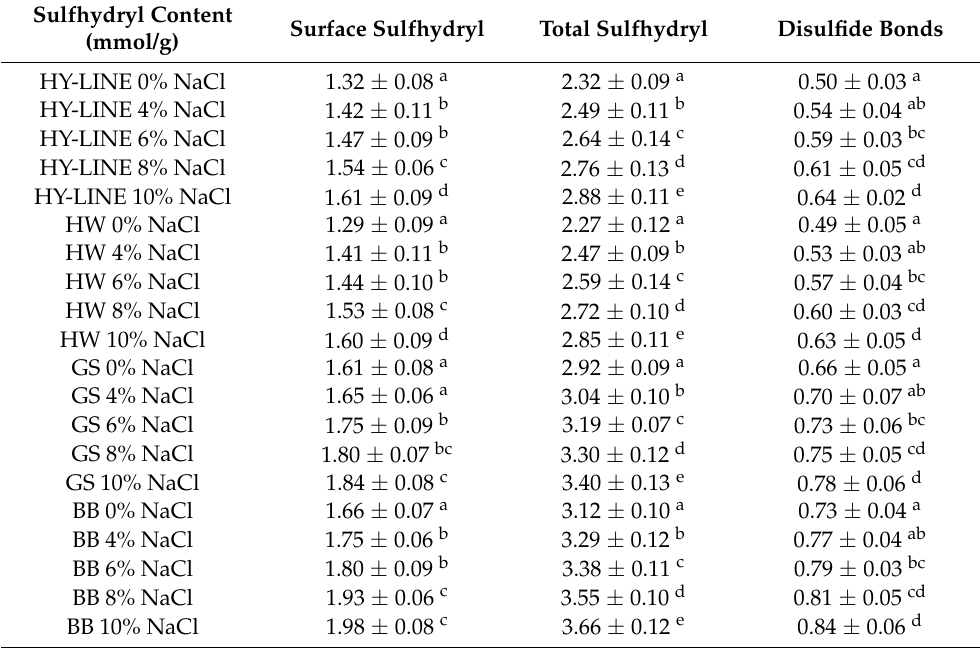
Means with different lowercase letters in the same column are significantly different at p < 0.05. Data are the means ± standard deviations of three replicates. Three replicate samples were measured for each treatment. Table 2. Contents of the surface sulfhydryl groups, total sulfhydryl groups and disulfide bonds of four varieties after addition of sucrose and subjection to heat treatment.